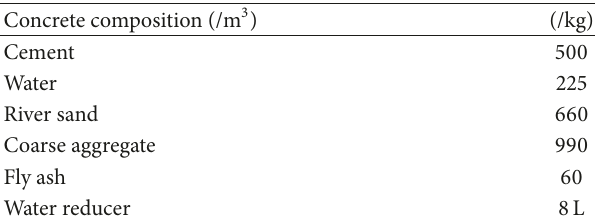
Table 1: The proportions of concrete